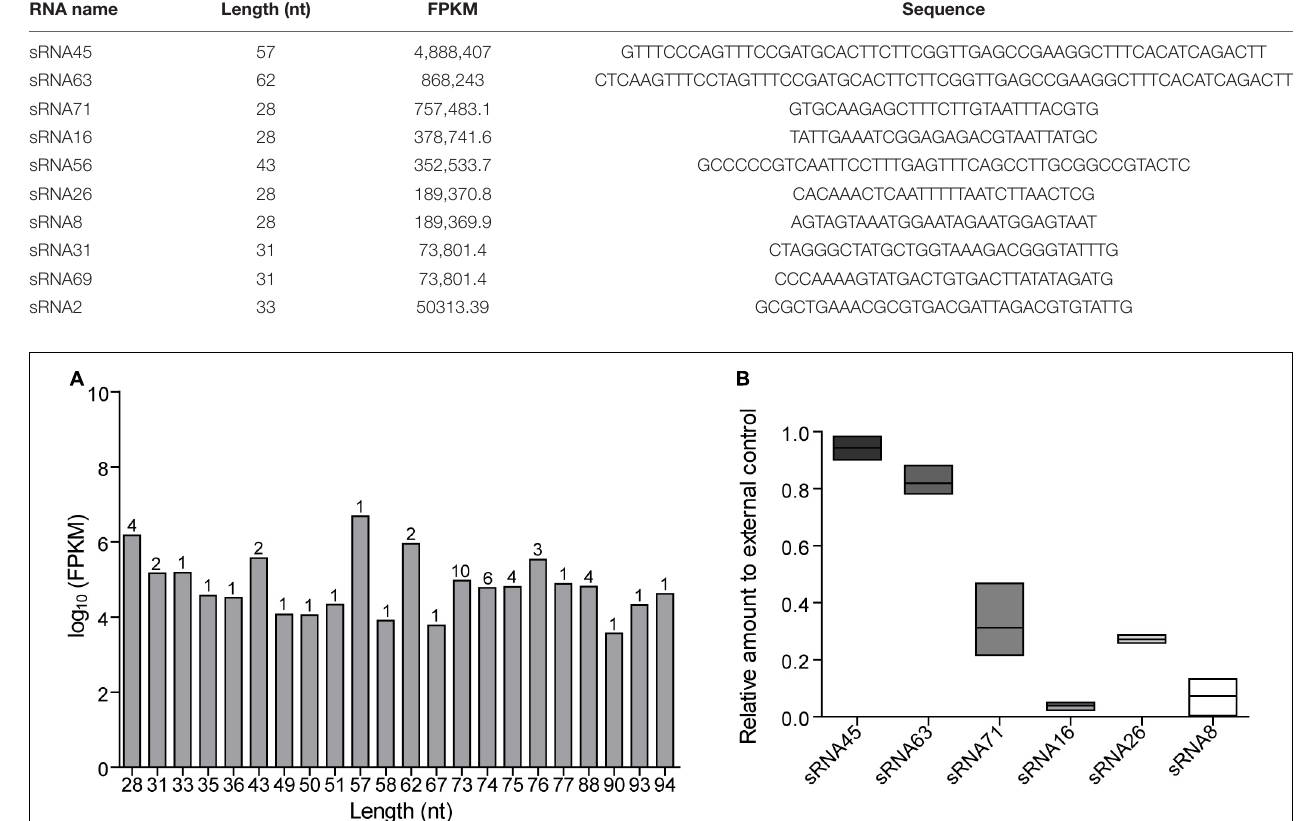
FIGURE 1 | RNA sequencing results and relative expression levels of sRNAs in LDEVs. (A) Length distribution of sequenced sRNAs. The numbers on the columns represent the number of sRNAs of the same length. (B) The relative amount of each sRNA was determined via RT-PCR. About 1 pmol external control and standard curve were used for calculation. Data were shown as mean ± SEM ( n = 3 biological replicates). The results were presented using GraphPad Prism